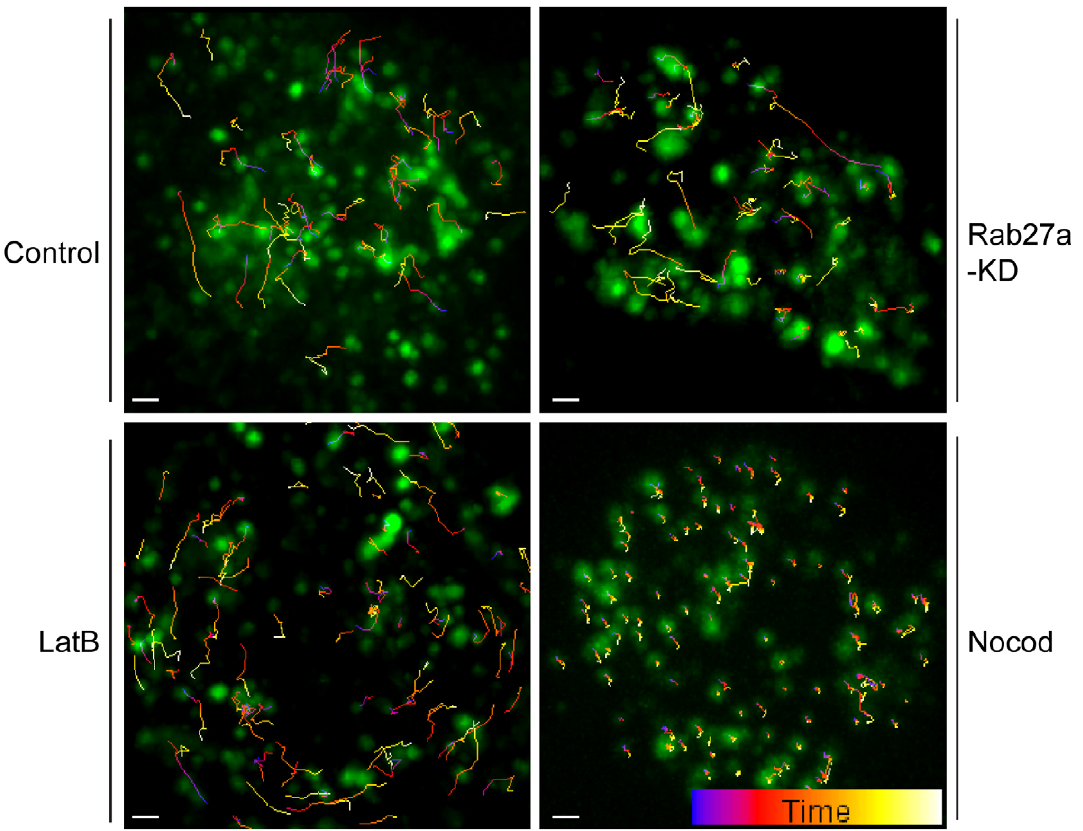
Figure 3. 3D movement of single LG tracked in live NK cells. Single vesicle tracks are superimposed on maximum intensity projections of image stacks as used for the tracking analysis (see Material and Methods). The x-y plane (which is shown) is projected in the z direction. NKL cells were either untreated (control), or treated with 10 m M LatB, 10 m M Nocod, or after Rab27a-KD, as indicated. LG were labeled by expression of FasL- GFP. The colors of tracks indicate the time, according to the color bar (start = blue, end = yellow). Scale bar is 1.0 m m.